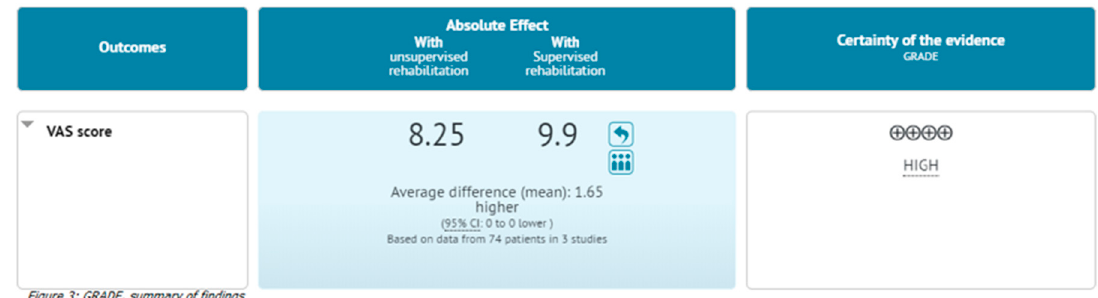
Figure 3. GRADE, summary of findings.